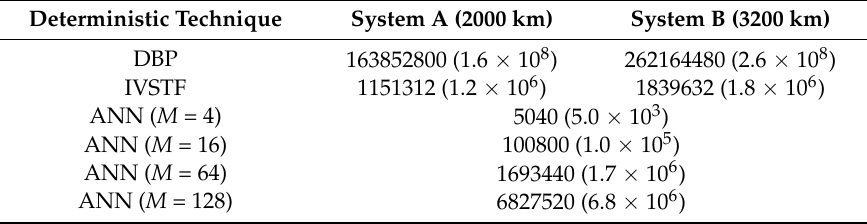
Table 3. Computational complexity comparison between full-step DBP, IVSTF and ANN for different modulation format order ( M ) and transmission